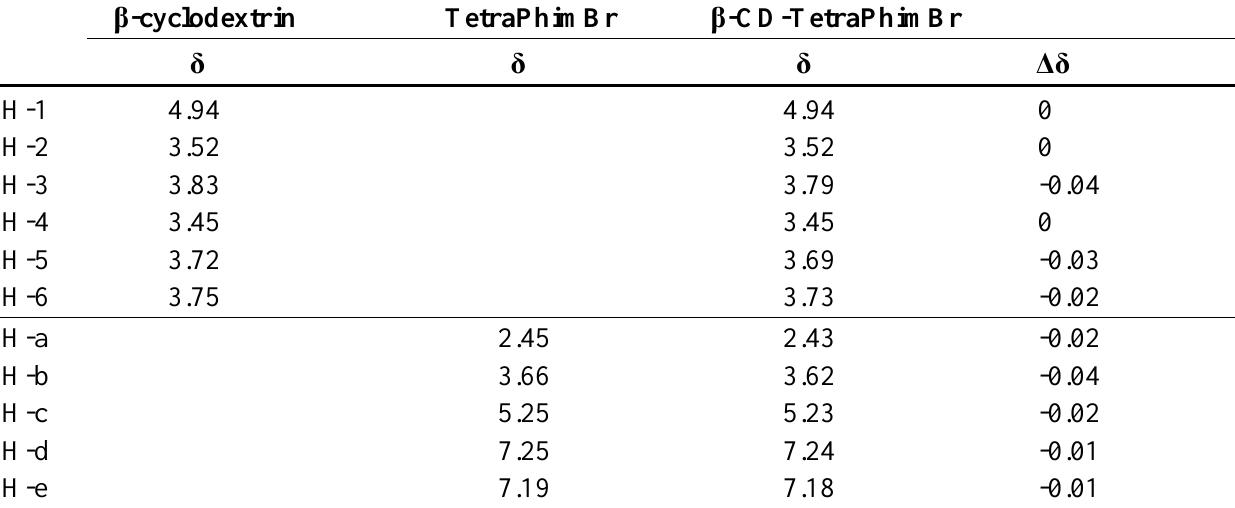
Table 1. The chemical shifts (δ) of β-cyclodextrin, TetraPhimBr and